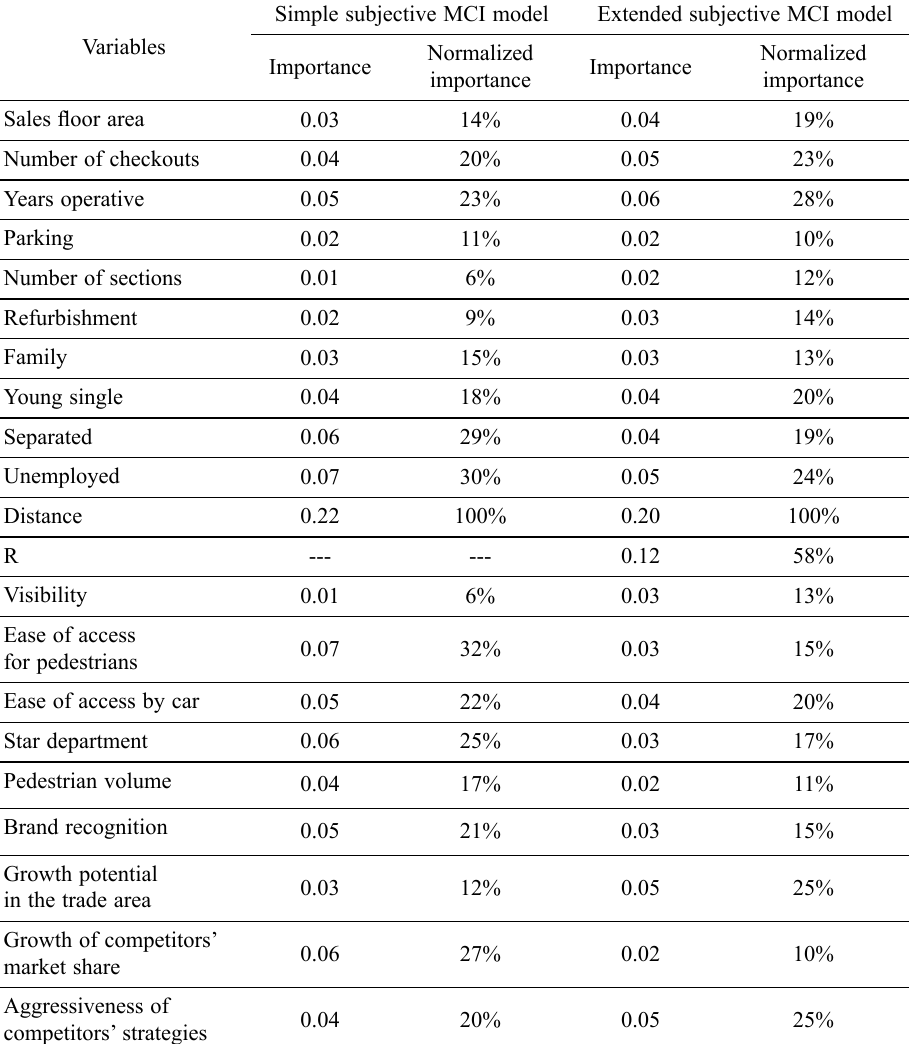
Table 4. Importance of independent